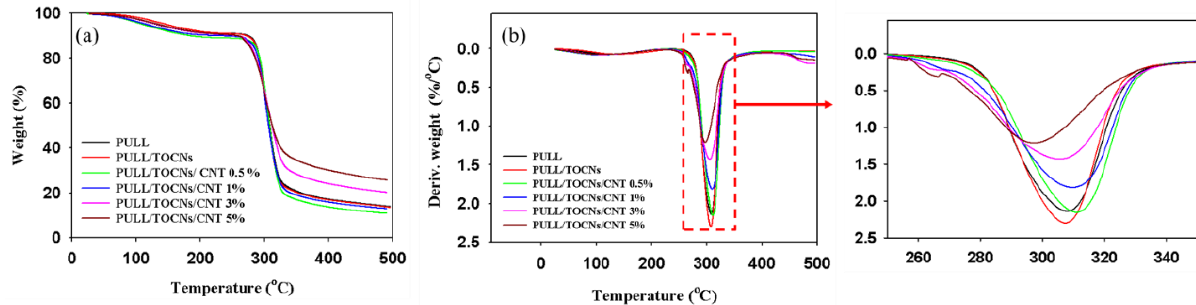
Figure 5. TGA ( a ) and differential thermal gravimetric (DTG) ( b ) results of neat PULL and PULL/TOCNs/CNT (0% – 5%) composite films.